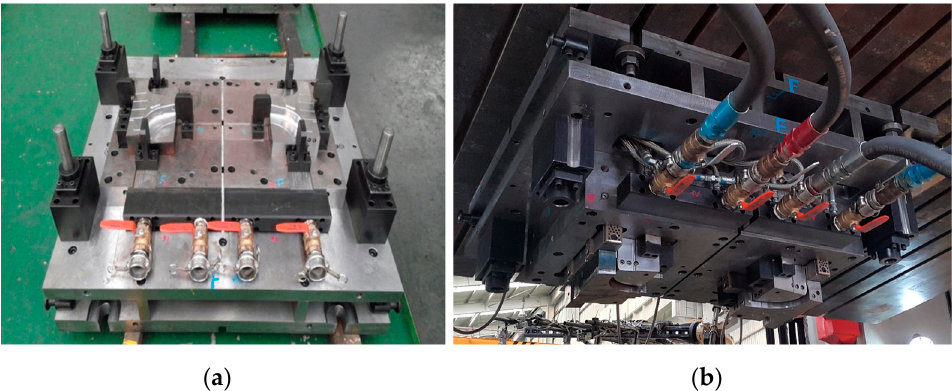
Figure 17. Assembled cooling block body ( a ) lower punch cooling block combined with the die body